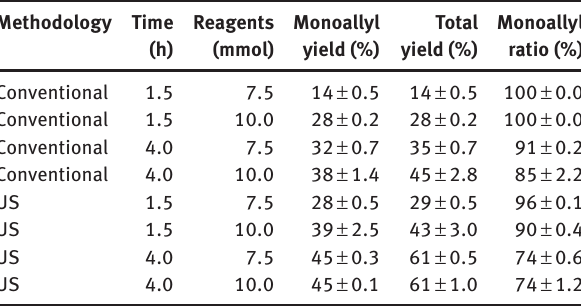
Table 2: Experimental conditions to evaluate the methodology, time reaction, and quantity of